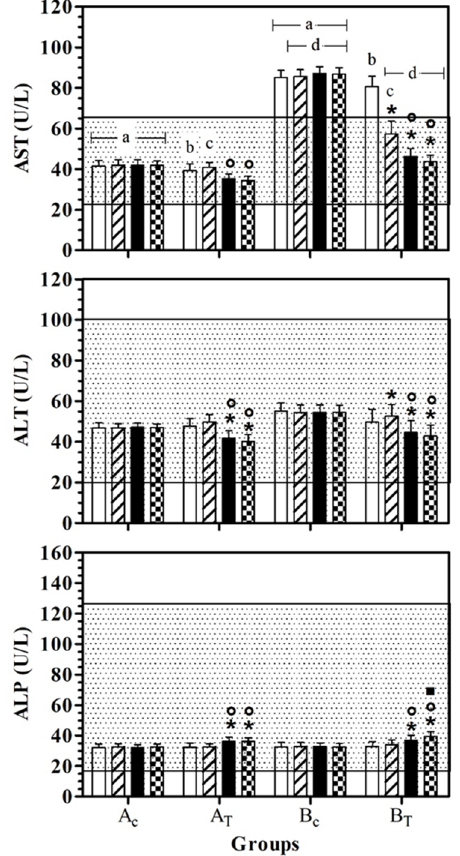
Figure 2. Mean ± standard deviation (SD) of serum liver enzymes used as inclusion criteria (aspartate aminotransferase—AST, alanine aminotransferase—ALT; alkaline phosphatase—ALP) recorded for the different data points ( T3) of the experimental protocol,